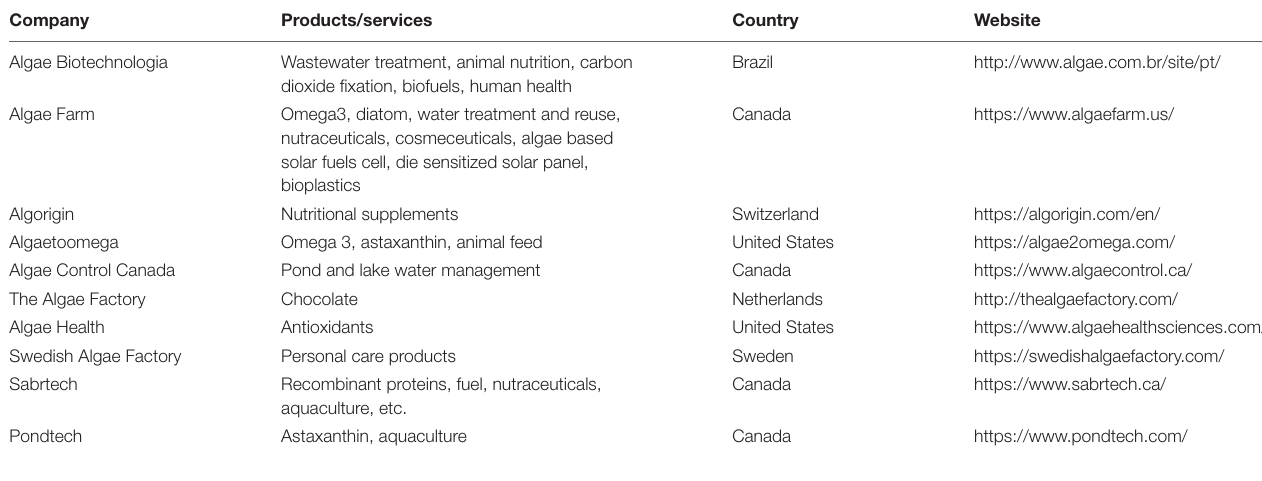
TABLE 3 | Different industries producing variety of products from microalgae and diatoms around the world.